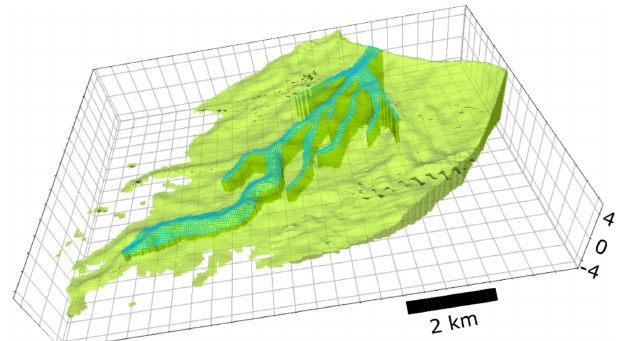
Figure 3. 3-D geometry of the Attakapas Crevasse Splay. Vertical axis is in meters relative to NAVD 88. The relatively sandy chan- nel deposits are shown in blue green; light green refers to the silt- dominated portion of the splay. Channel deposits make up 16% of the total volume, and non-channel deposits compose the remain- ing 84%. The transparent top bounding surface is the lidar-derived modern land surface, and the base is the clay to silt transition shown in Fig. 4. Wherever possible, the lateral boundary is chosen to be the intersection of the top and basal bounding surfaces. On the lateral edges, where the deposit does not pinch out and these two surfaces do not meet, the boundary was chosen